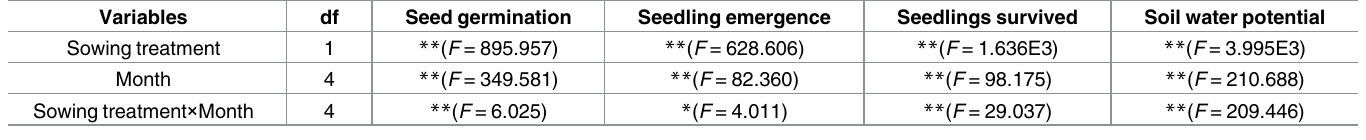
Table 1. Significance level of the effectsof factors and factor interactions on variables based on repeated-measureone-way ANOVA. Variables df Seed germination Seedling emergence Seedlings survived Soil water potential Sowing treatment Month Sowing treatment ×